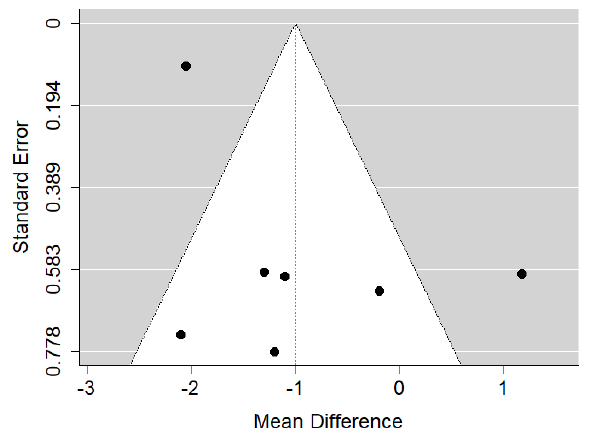
Figure 13. Funnel plot of ANB values for the comparison of patients with cleft palate only treated surgically and orthodontically vs. non-cleft healthy population [19,22,29,32,33].